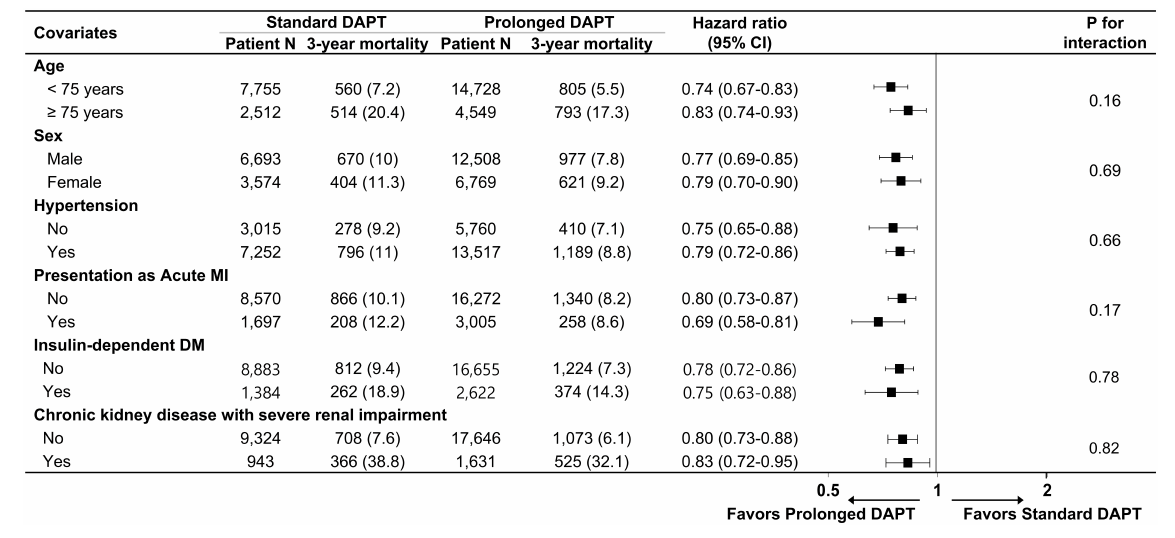
FIGURE3 Subgroup analysis for all-cause death in diabetic patients. Numbers and percentages show the number of patients at risk and the all-cause mortality rate between 1 and 3 years after drug-eluting stent implantation. CI, confidence interval; MI, myocardial infarction; DM, diabetes